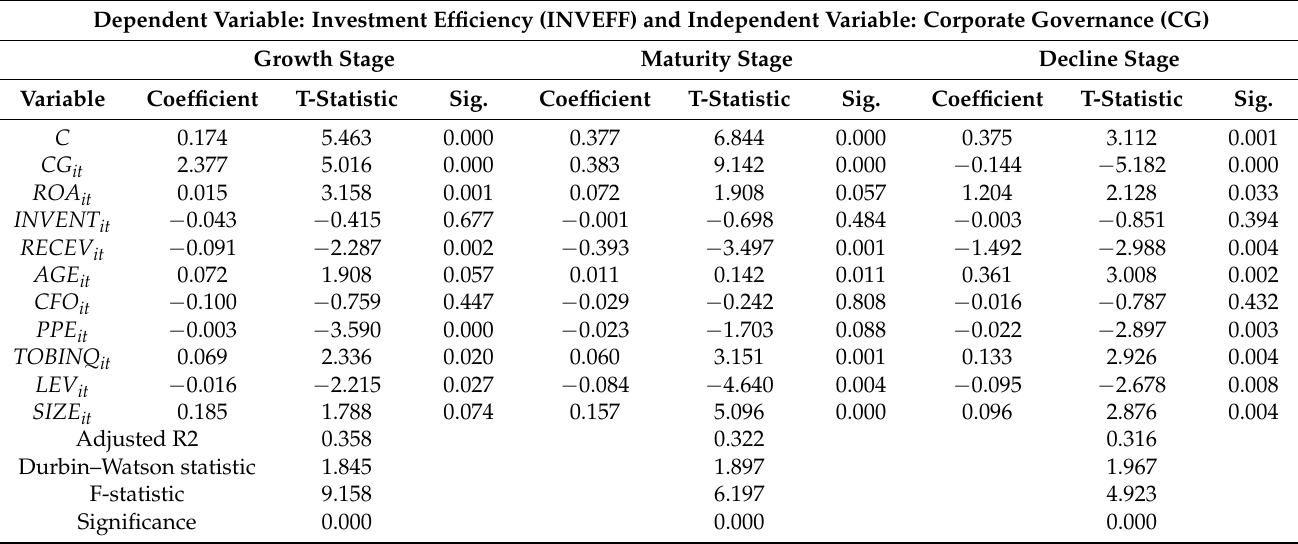
Table 10. The results of the statistical test of the first hypothesis in the life cycle stages.